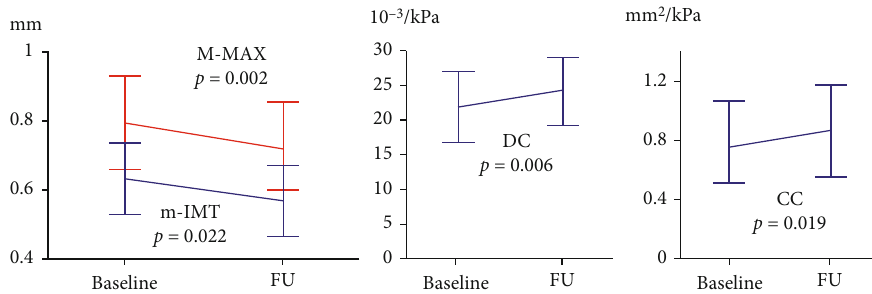
Figure 2: Ultrasound parameters at baseline and follow-up. Carotid ultrasound examinations were performed at enrollment and after 12 months. At the end of the treatment, we observed a small but signi fi cant reduction in both mean-IMT and M-MAX, and improvement in carotid elasticity (m-IMT: cumulative mean of mean IMT recorded in each carotid artery segment on both sides; M-MAX: cumulative mean of maximum IMT recorded in each carotid artery segment on both sides; DC: distensibility coe ffi cient; CC: compliance coe ffi